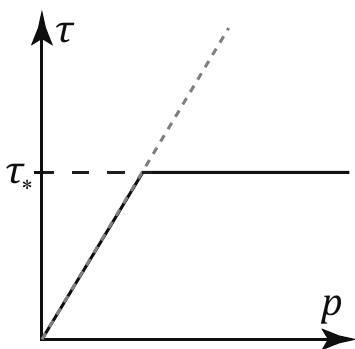
Figure 3. Grigorian friction